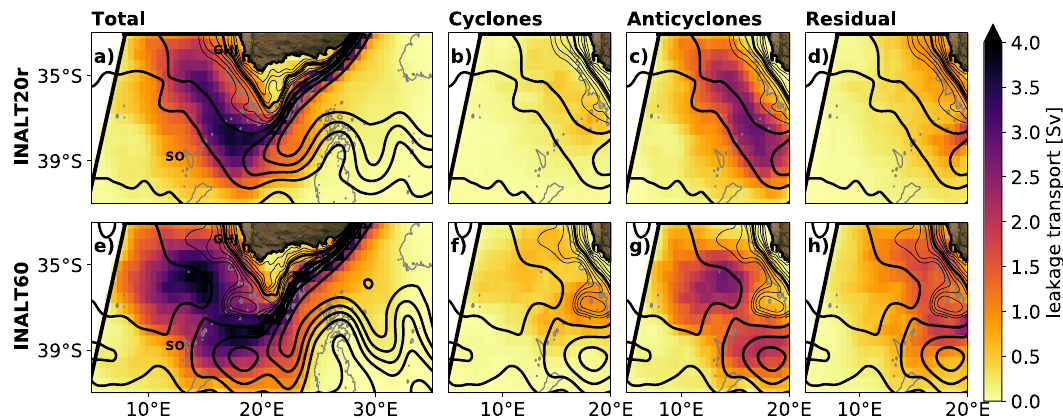
Fig. 3 Submesoscale fl ows broaden the Agulhas leakage pathway and enhance the leakage mainly by leading to a stronger Agulhas fi lament pathway. Single-count cumulative transport of leakage particles normalised by the number of seeding days (colours) from INALT20r ( a – d ) and INALT60 ( e – h ) for the seeding period 2011 – 2014 and the full trajectories ( a , e ), as well as for leakage particles that sojourn in mesoscale cyclones ( b , f ), anticyclones ( c , g ) and outside of mesoscale eddies ( d , h ) within the Cape Basin. The bin size is 1/2 ∘ × 1/2 ∘ . Black contours show the 2012 – 2017 mean sea-surface height with contour intervals of 20 cm (thick), as well as of 2 cm between − 30 cm and − 10 cm north of 37. 5 ∘ S (thin) to highlight the location and strength of the time-mean lee cyclone and the Good Hope Jet (GHJ). Black straight lines mark the position of the Good Hope Line. Grey contours show 300 m and 3000 m isobaths. The position of the Schmitt-Ott seamount (SO) is marked. For land areas a satellite picture is shown 49